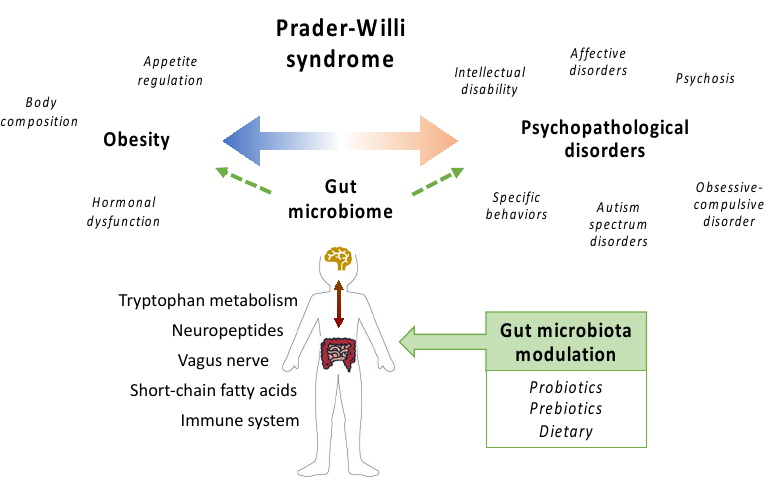
Figure 1. Gut microbiota and Prader-Willi syndrome.